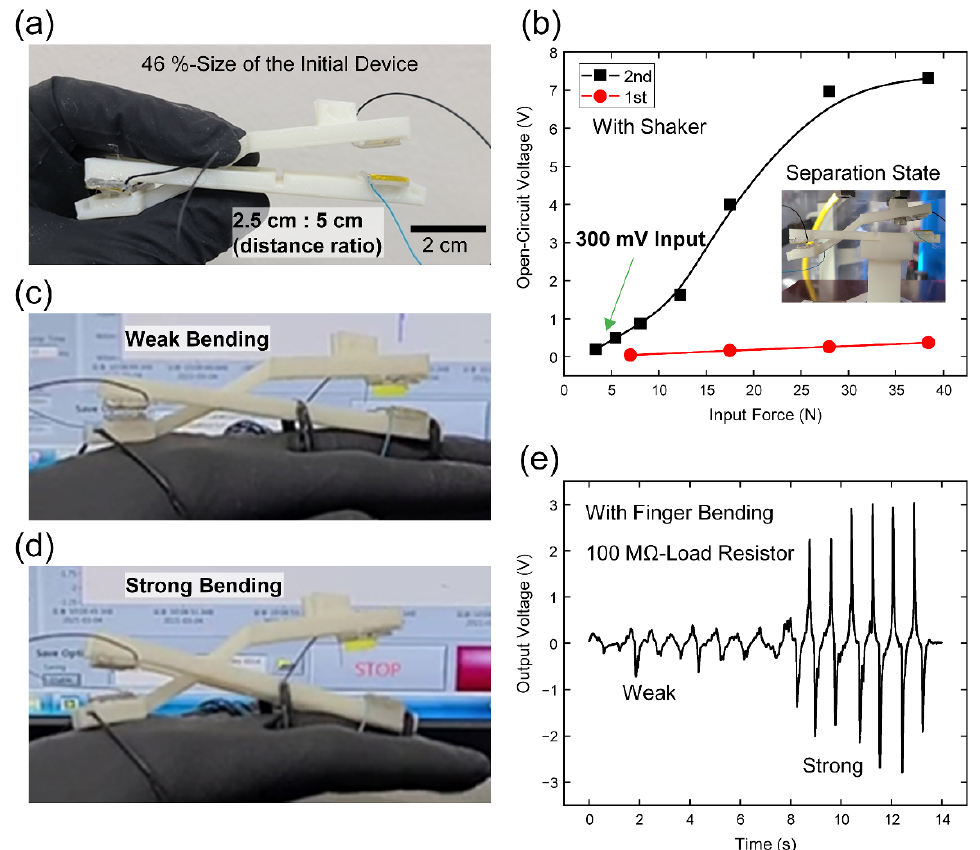
Figure 6. Weak-bend sensing ability of the L-TENG. ( a ) Digital camera image of the L-TENG with decreased size. ( b ) V OC -force characteristic with the 1st part- and 2nd part-TENGs. Digital camera images for displaying the finger bending and operating states of L-TENG with ( c ) weak bending case and ( d ) strong bending case. ( e ) Output voltage results of L-TENG from the two finger bending states.